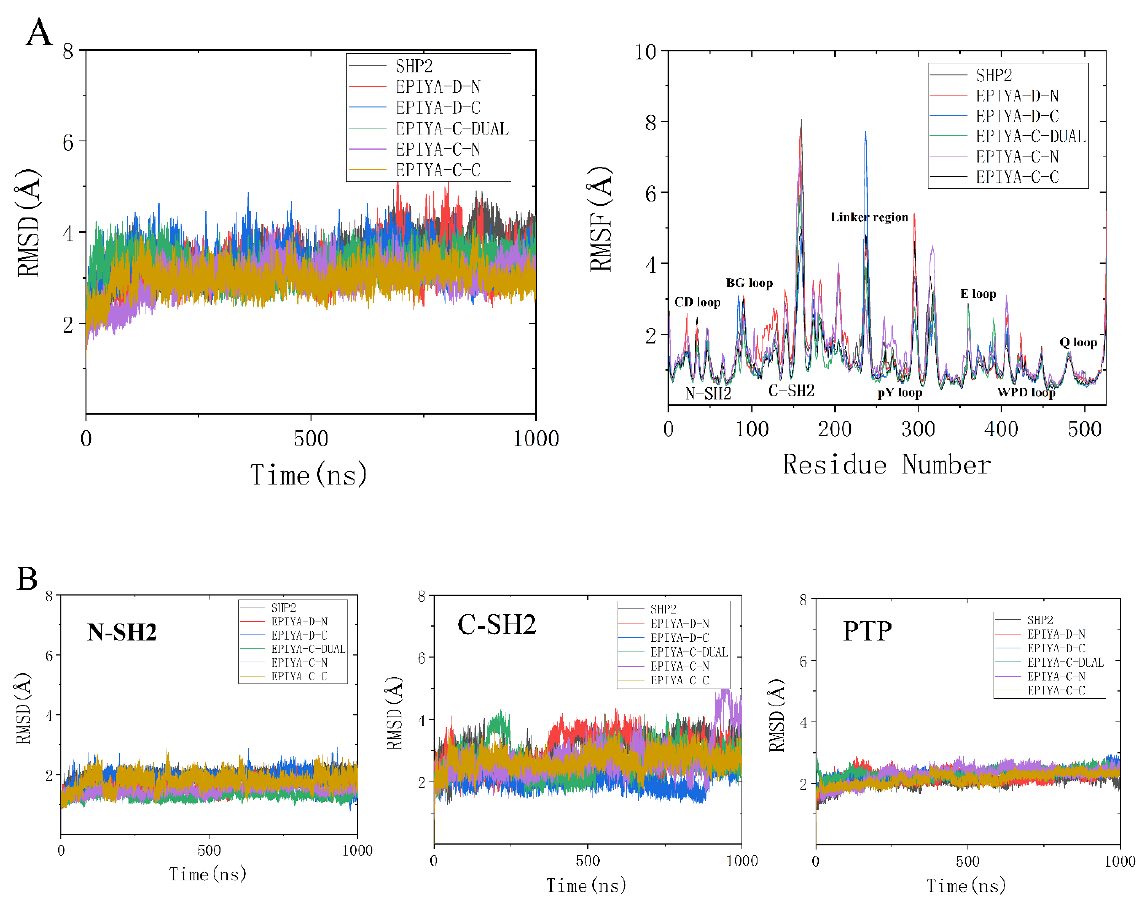
Figure 2. RMSD values and RMSF values of SHP2 in all systems ( A ), and the RMSD values of N-SH2, C-SH2 and PTP domains in all systems ( B ).